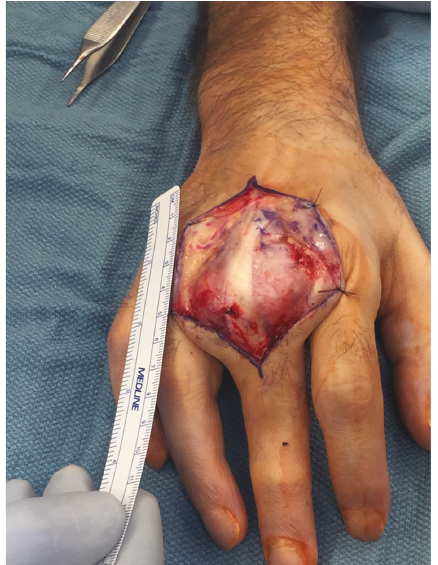
Figure 4: Gross surgical image of dissection/approach.